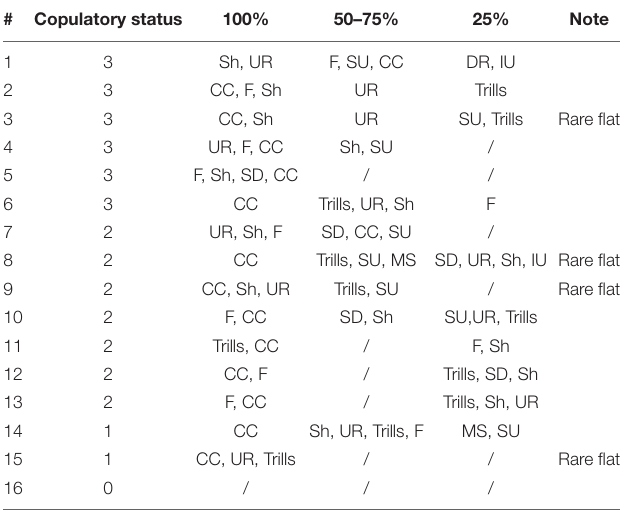
TABLE 1 | PVs and ultrasonic subtypes during consecutive sessions.